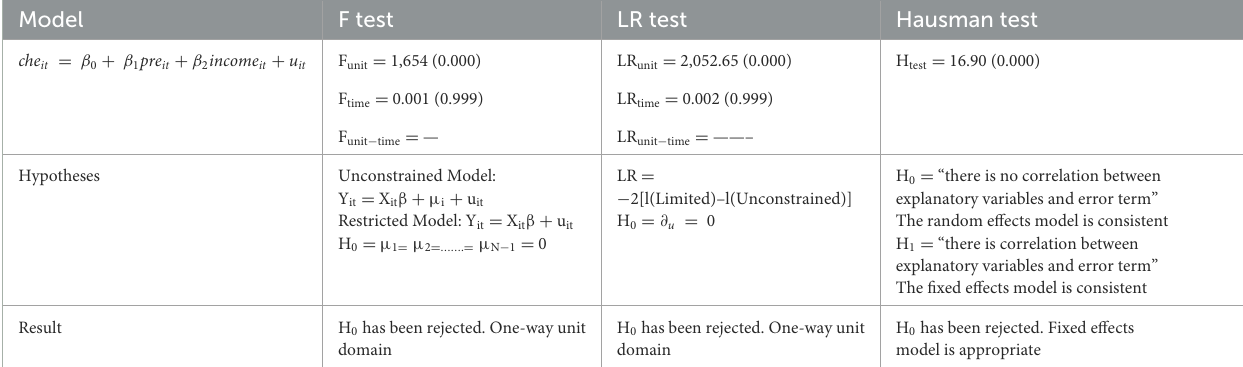
TABLE 2 F, LR, and Hausman test results.